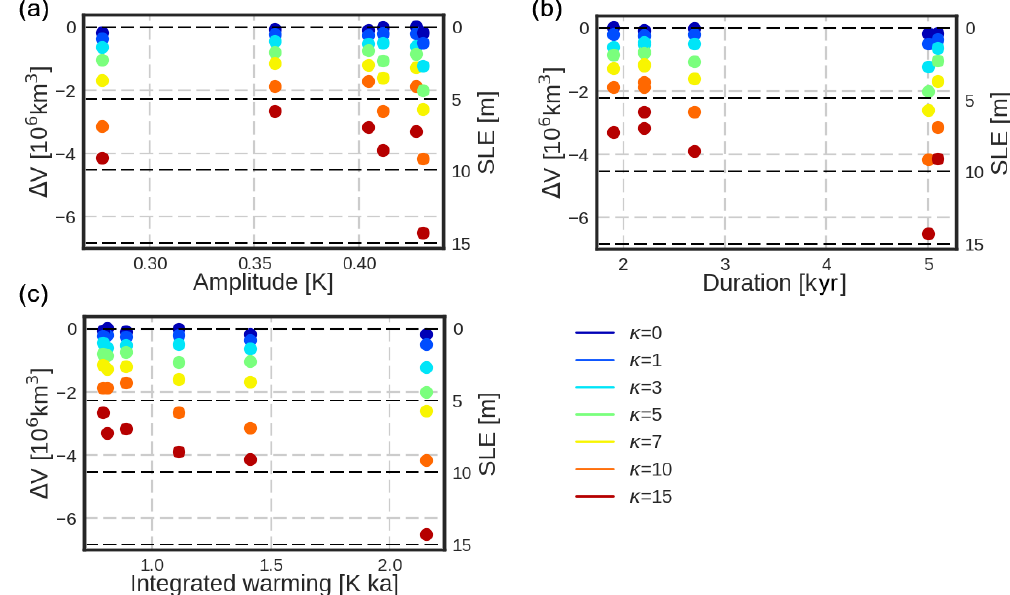
Figure 8. Ice-volume discharge and SLE contribution of every event against (a) the amplitude of the warming, (b) the duration of the warming phase, and (c) the integrated warming defined as the peak warming times the duration. Colors represent the different ice–ocean